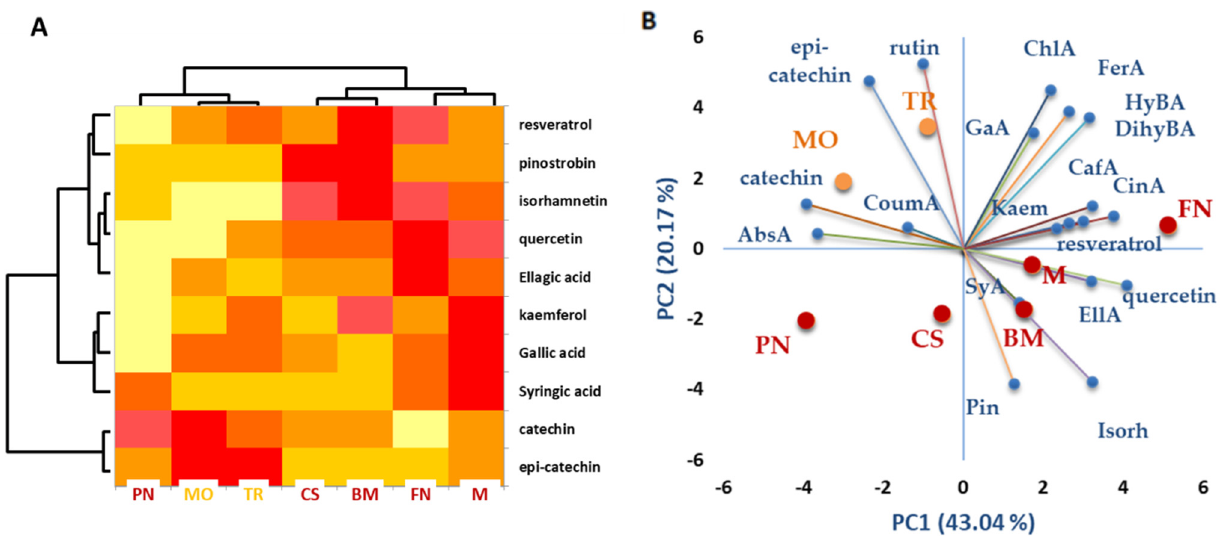
Figure 5. Differentiation of grape pomace based on the main quantified phytochemicals: Heat map ( A ) and PCA ( B ) (MO-Muscat Ottonel, TR-Tamaioasa Romaneasca, PN-Pinot Noir, CS-Cabernet Sauvignon, FN-Feteasca Neagra, M-Merlot, BM-Burgun Mare).